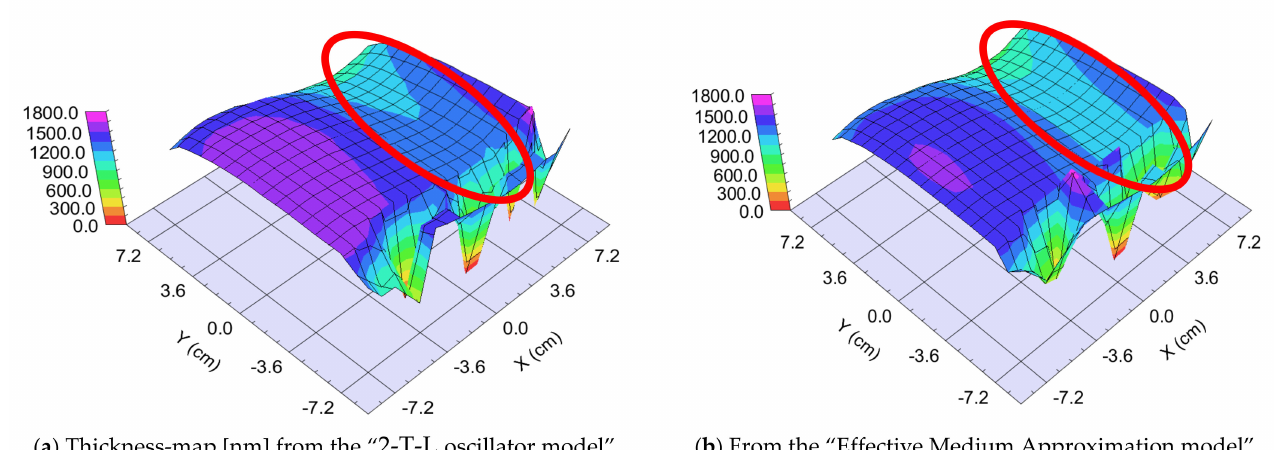
Figure 13. Thickness-maps ( a ) using the 2-Tauc-Lorentz (2-T-L) oscillator model ( b ) and the Effective Medium Approximation model. Red ellipses show the interesting area, where the composition changes the most. We show only one 15 × 15 cm part, all other parts show the same tendencies.